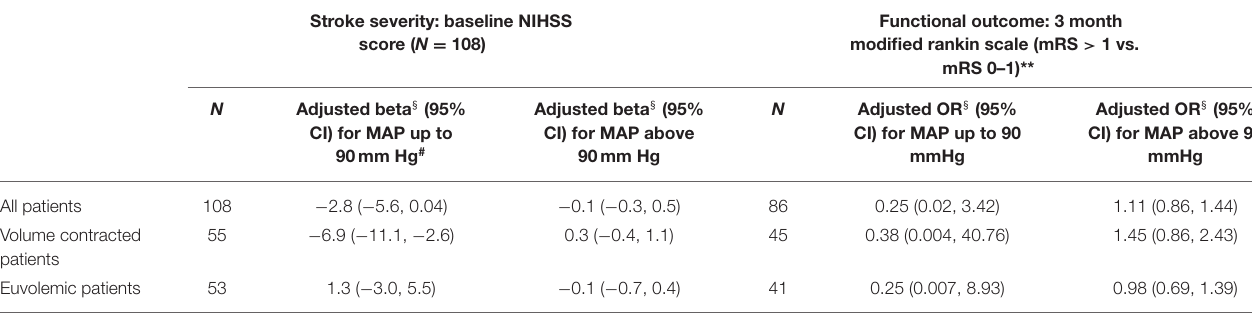
TABLE 2 | Effect of mean arterial pressure (per 10mm Hg) on stroke severity and outcome: multivariable regression analysis. Stroke severity: baseline NIHSS score ( N = 108)